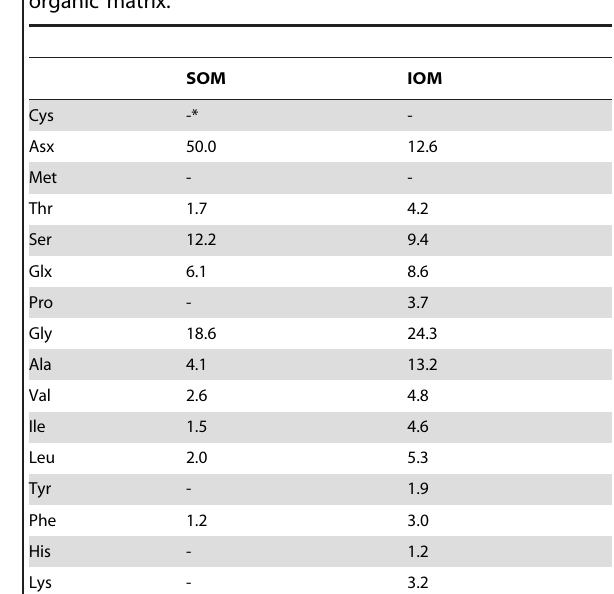
Table 1. Amino acid compositions (relative mol %) of proteins extracted from the soluble (SOM) and insoluble (IOM) fractions of the Balanophyllia europaea skeleton intra-skeletal organic matrix.